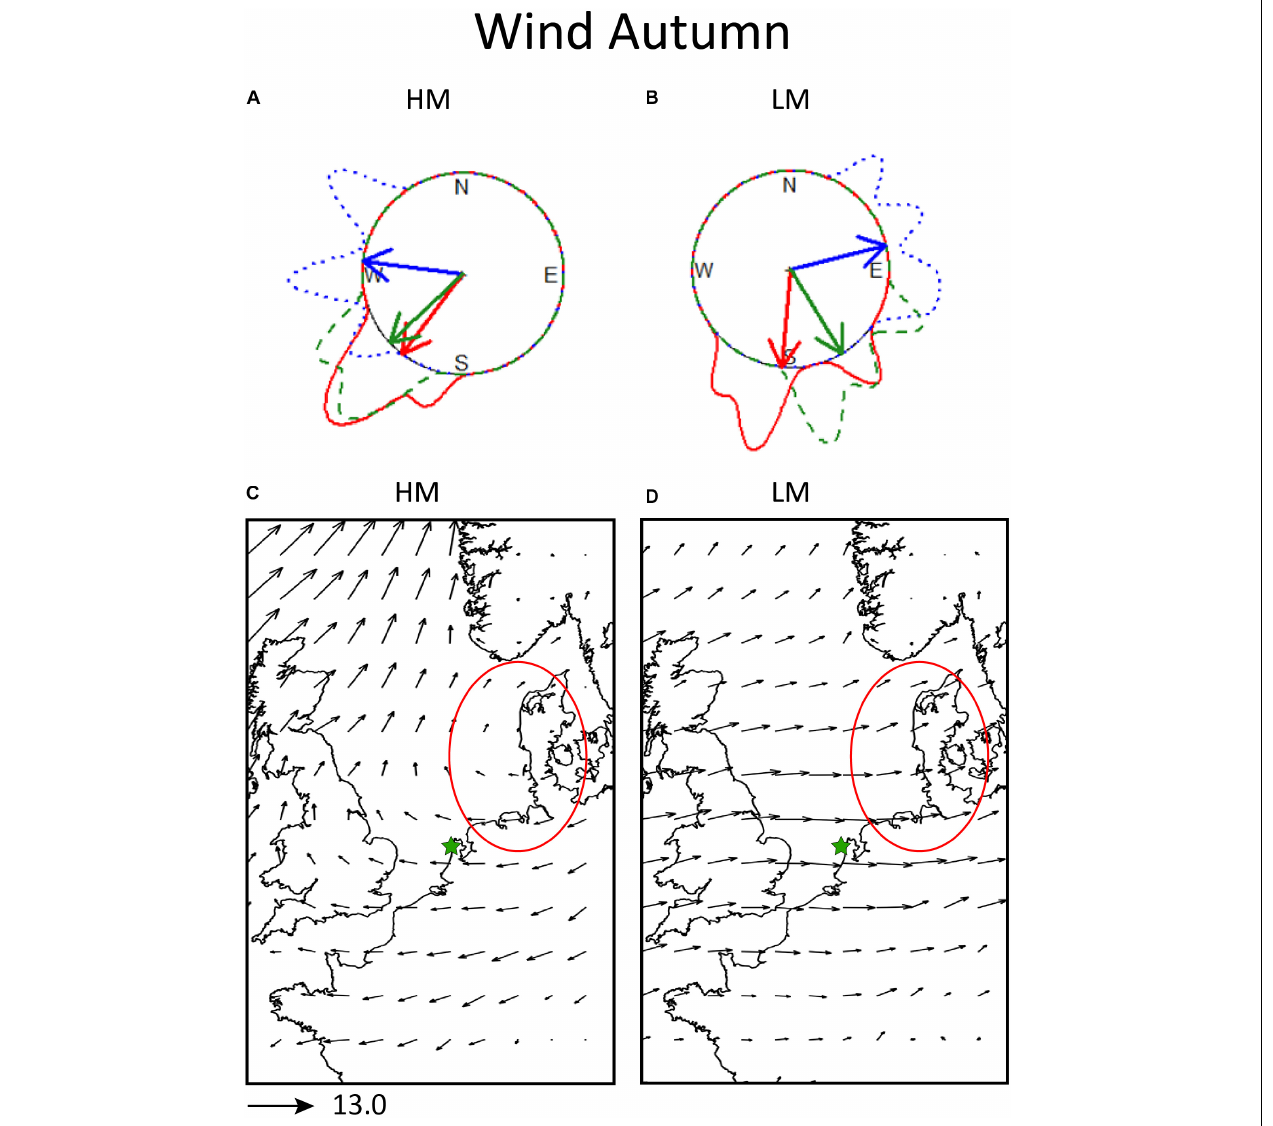
FIGURE 3 | Local and synoptic 925 hPa winds in autumn. Top panel: Inside each circle, the mean heading of the birds (red arrows), mean 925 hPa wind direction at the radar location (blue arrows) and mean track direction of the birds (green arrows). Around the circle, the circular density distributions of bird heading (solid line), wind direction (dotted line) and track direction (dashed line), in panel (A) for nights of high migration intensity (HM) and in panel (B) for nights of low migration intensity (LM). Bottom panel: synoptic 925 hPa wind conditions in autumn, in panel (C) for nights of high migration intensity (HM) and in panel (D) for nights of low migration intensity (LM). The length of the arrows is proportional to the strength of the averaged wind. As a reference the length of the arrow of 13 m/s wind strength is given under the panels. The circled area designates the most probable area of departure for the detected flying migrants during those nights. The star designates the location of the